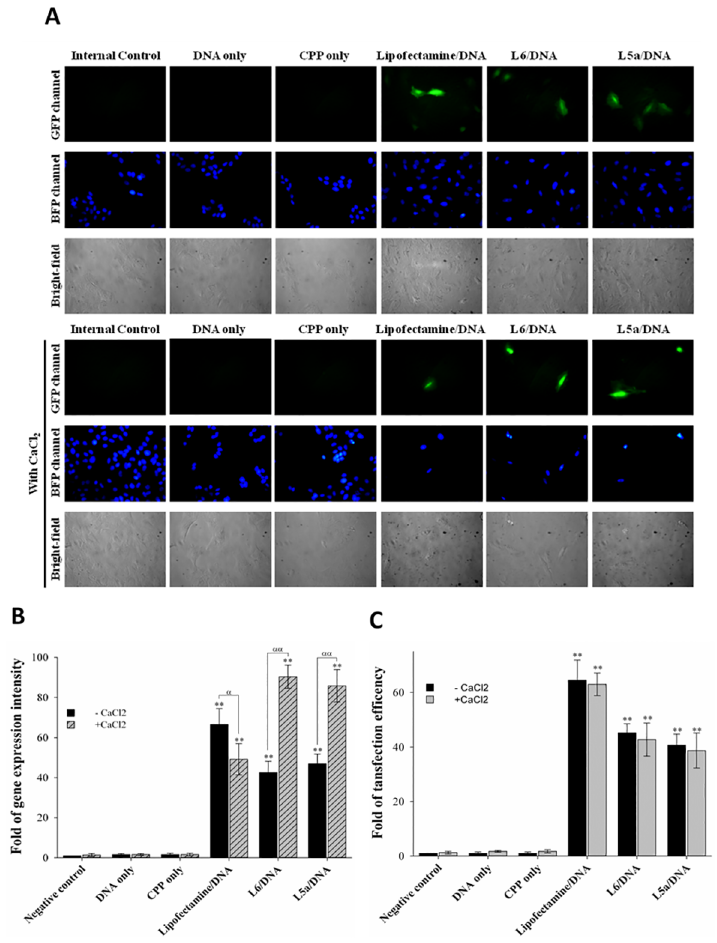
Fig 6. Influence of calcium chloride on CPP-mediated gene delivery. (A) Images of CPP-mediated delivery of the pEGFP-N1 plasmid DNA into cells in the absence or presence of calcium chloride. L6 or L5a was premixed with the pEGFP-N1 plasmid at an N/P ratio of 12. These CPP/DNA complexes, DNA alone, and CPP alone were incubated with cells for 1 h in the absence or presence of 113 mM CaCl 2 . Cells without any treatments and cells treated with Lipofectamine 2000/DNA complexes served as negative and positive controls, respectively. BFP and GFP channels revealed the distribution of nuclei stained by Hoechst33342 and EGFP, respectively. Cell morphologies were observed in bright-field images. All images are obtained using a Motic AE31 fluorescent microscope. (B) Fluorescent intensity of CPP-mediated delivery of gene expression. Fluorescent intensity recorded in panel A was quantified using UN-SCAN-IT software. Statistical comparisons were performed by ANOVA. Data are presented as mean ± SD from nine independent experiments in each treatment group. Experimental groups were compared with the negative control, and each group without CaCl 2 treatment was compared with the group with CaCl 2 treatment. Significant differences at P < 0.05 ( α ) and P < 0.01 ( ** , αα ) are indicated. (C) Transfection efficiency of CPP-mediated delivery of gene expression. Folds of transfection efficiency recorded in panel A were quantified using UN-SCAN-IT software. Data are presented as mean ± SD from nine independent experiments in each treatment group. Significant differences at P < 0.01 ( ** ) are